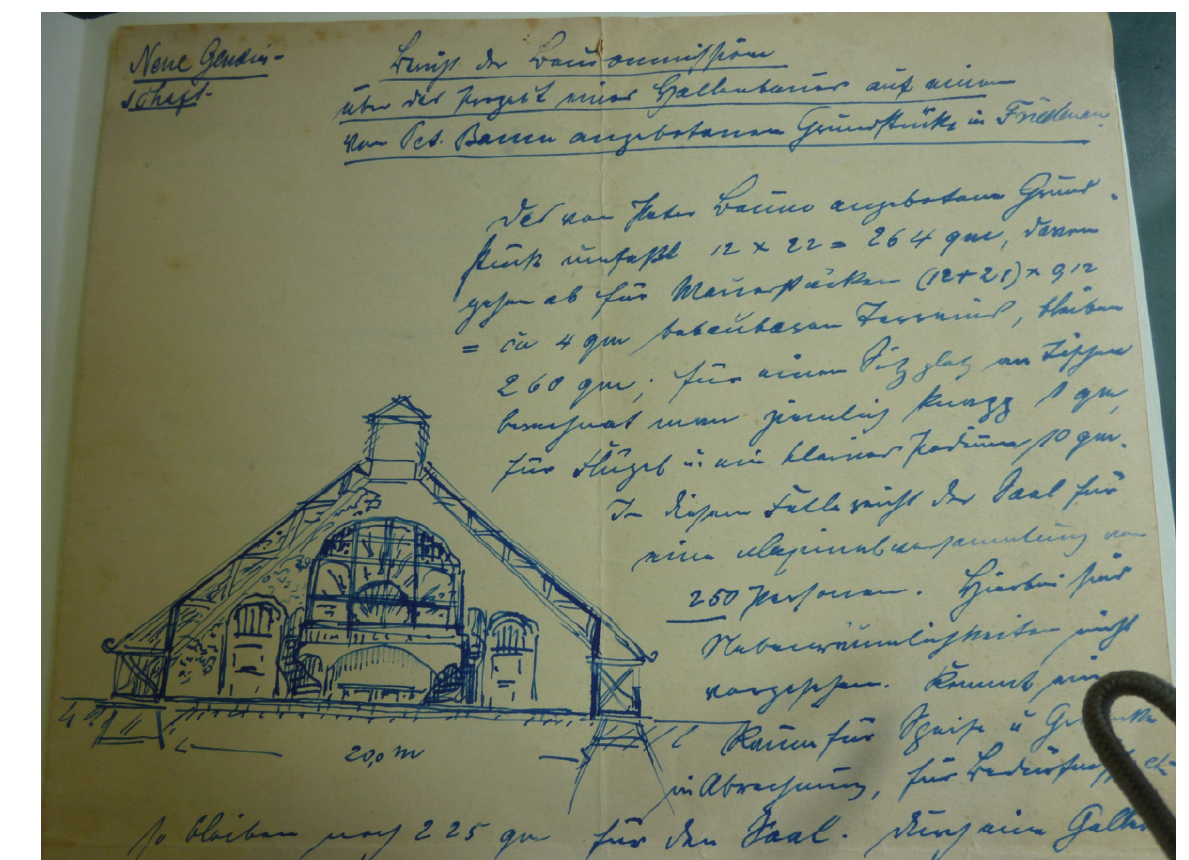
Figure 3. Bericht der Baucomission. Courtesy of the Stadt- und Landesbibliothek Dortmund (StLB Dortmund, JHN Nr. 2864).